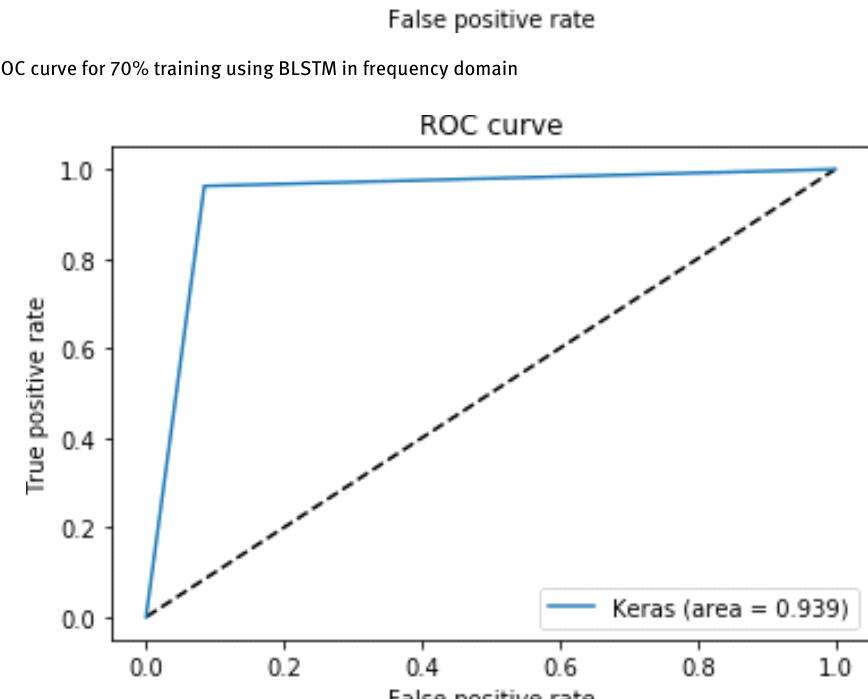
Figure 15: ROC curve for 80% training using BLSTM in frequency